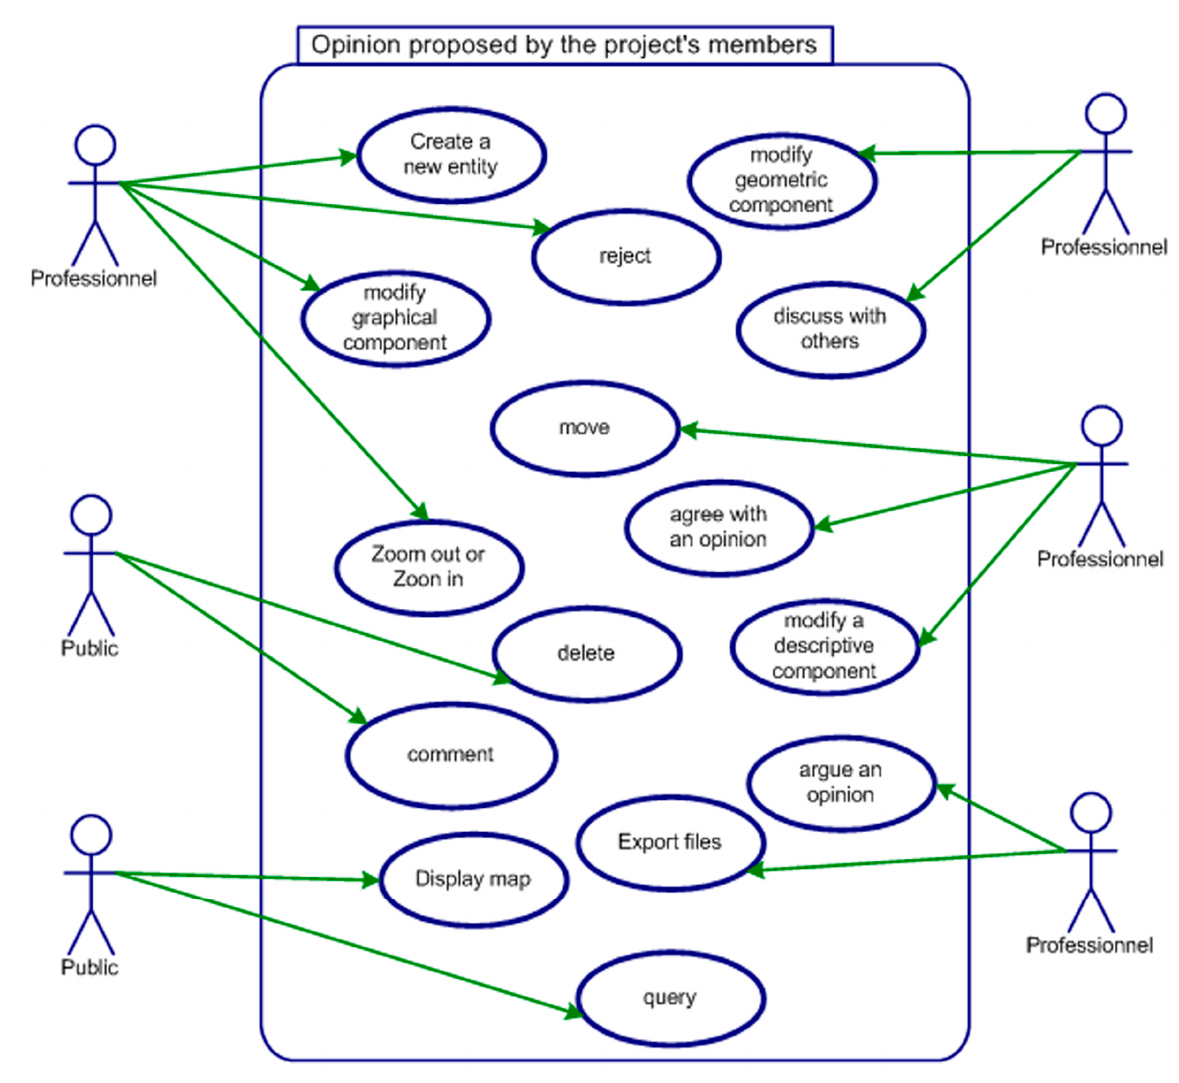
Figure 13. The behavior of site organizers within the